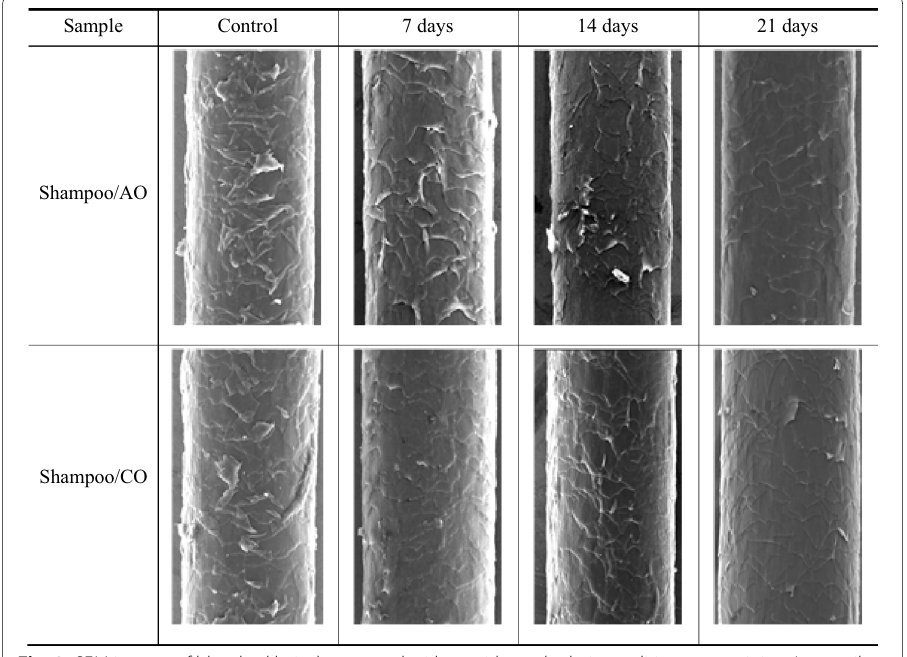
Fig. 3 SEM images of bleached hair shampooed with or without the hair conditioner containing Argan oil (AO) or Camellia oil (CO)